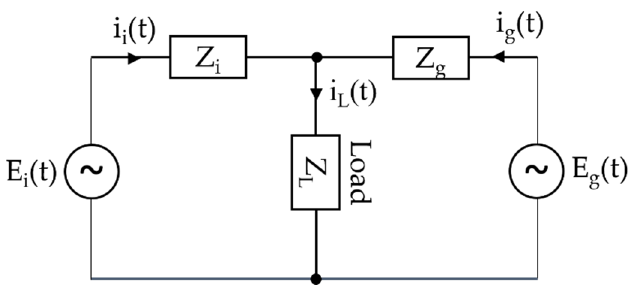
Figure 2. Equivalent model of SG connected with DG.